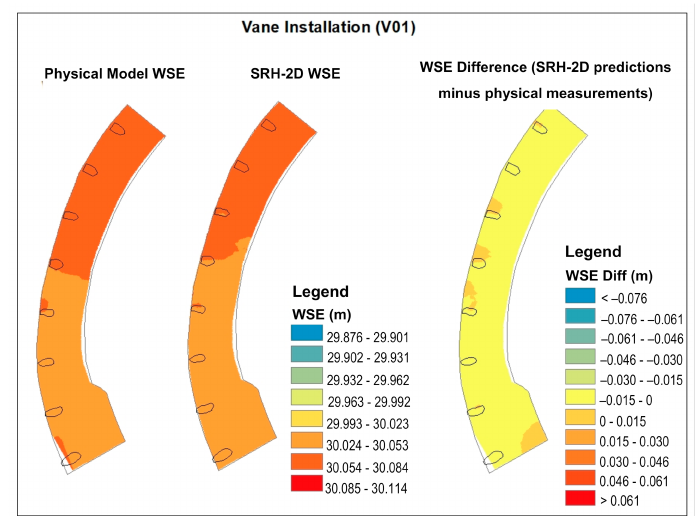
Figure 18. Rock vane configuration V01 comparison of physical model-measured and SRH-2D- predicted WSE values.